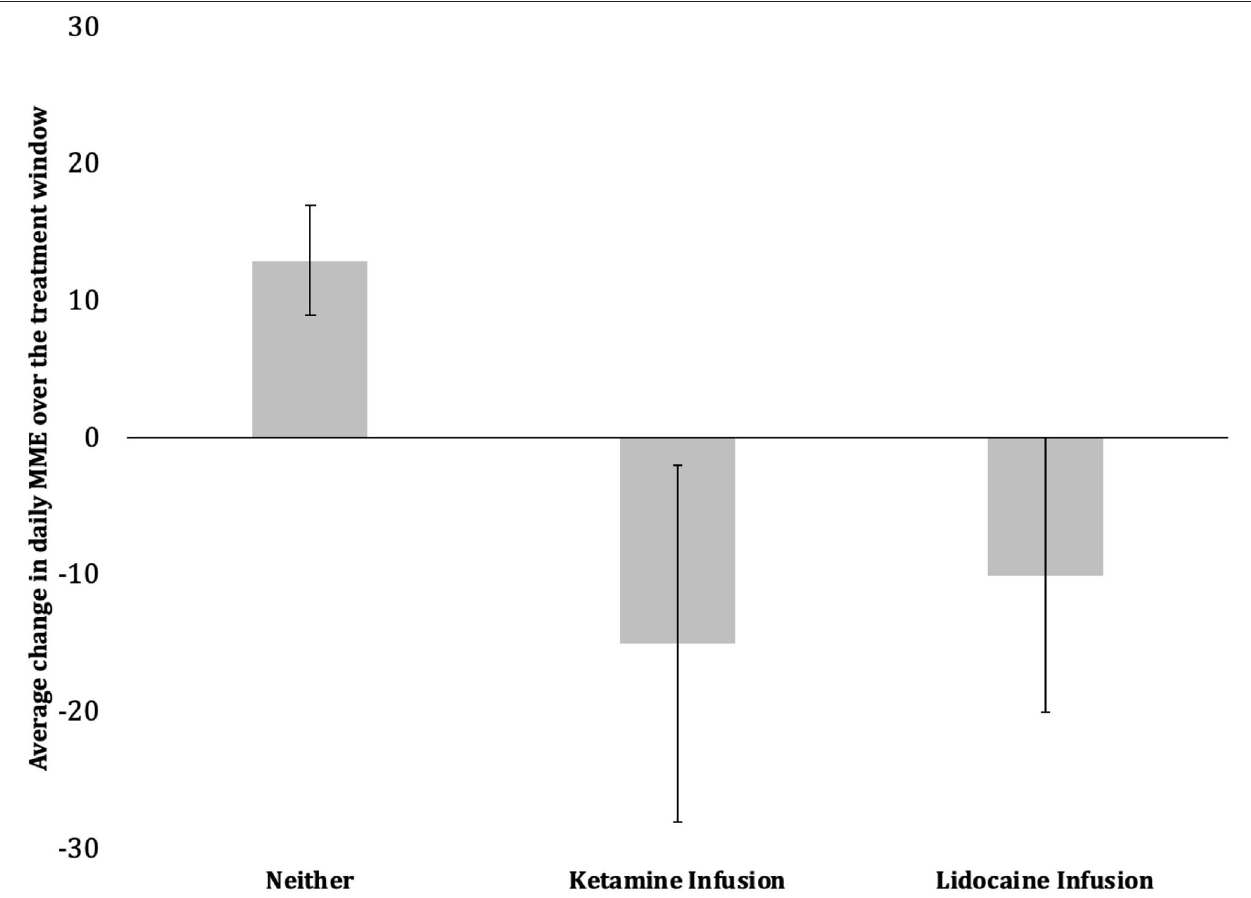
FIGURE 2 | Comparison of change in average daily oral morphine equivalents between encounters with infusion therapy and those receiving standard care. Data are mean change in opioid consumption over treatment window ( ± 1 SE). The ketamine group and the lidocaine group are significantly different from the standard-care group (p = 0.02, p = 0.03;